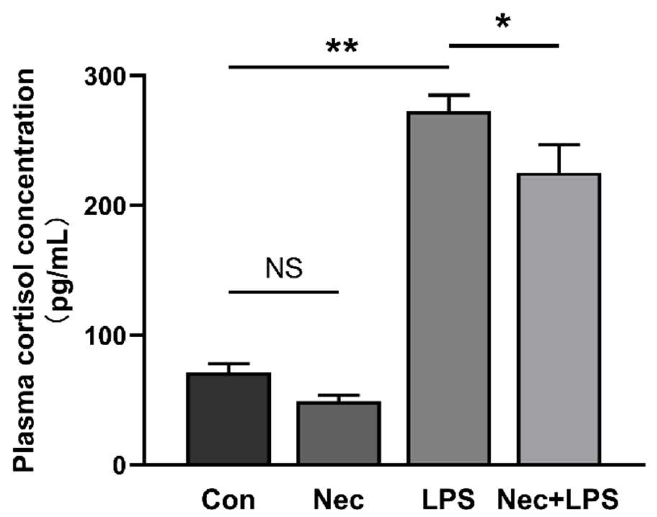
Figure 7. Nec-1 reduces plasma cortisol concentration. The pigs were pretreated intraperitoneally with Nec-1 at 1.0 mg/kg BW or equal volume of 2% DMSO solution 30 min before the intraperitoneal injection of LPS or saline, and the pigs were sacrificed at 4 h after LPS or saline injection. Values are means ± SEM, n = 7. NS means no significance, * p < 0.05, and ** p < 0.01.